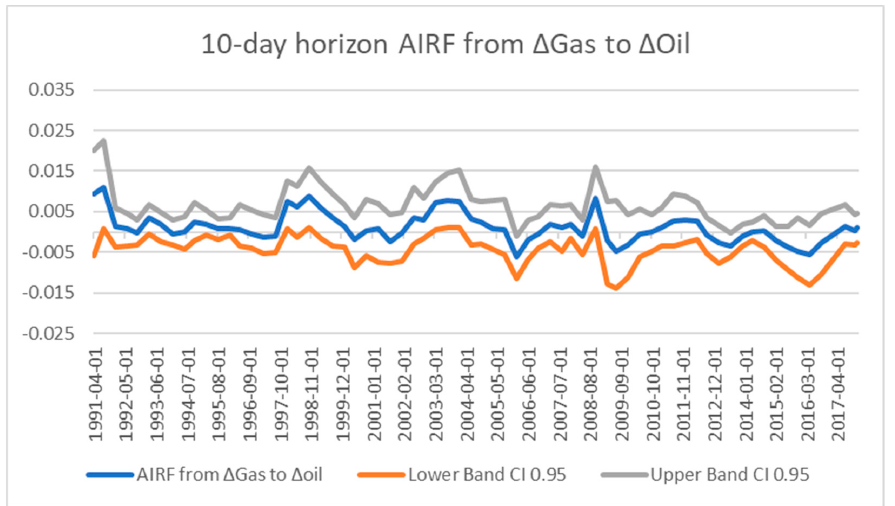
Figure 7. 10-day horizon accumulated impulse response functions (AIRF) from Gas to Oil (in %).